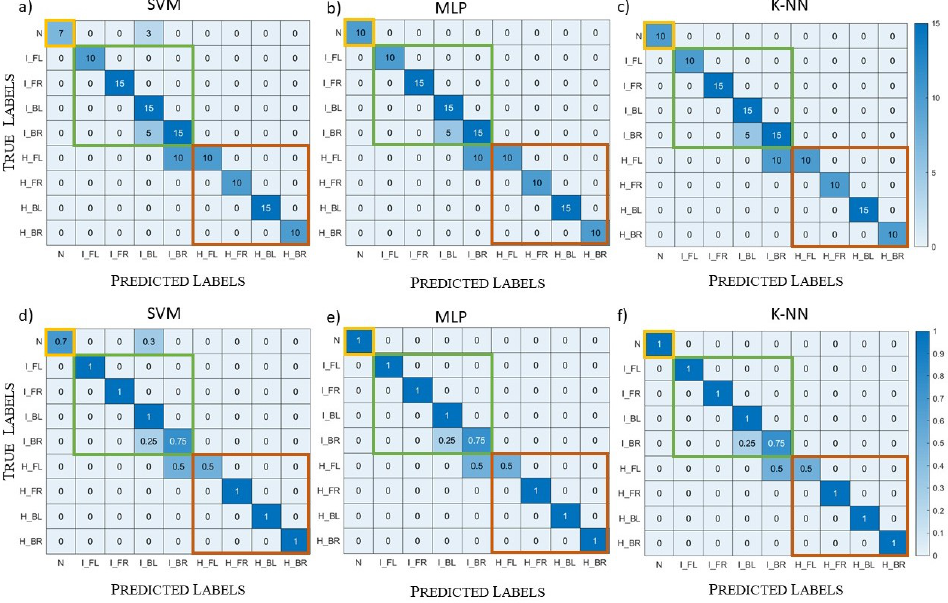
Figure 12. System A testing case, complex datasets: ( a – c ) confusion matrices; ( d – f ) normalized confusion matrices; ( a , d ) SVM results; ( b , e ) MLP results; ( c , f ) k-NN